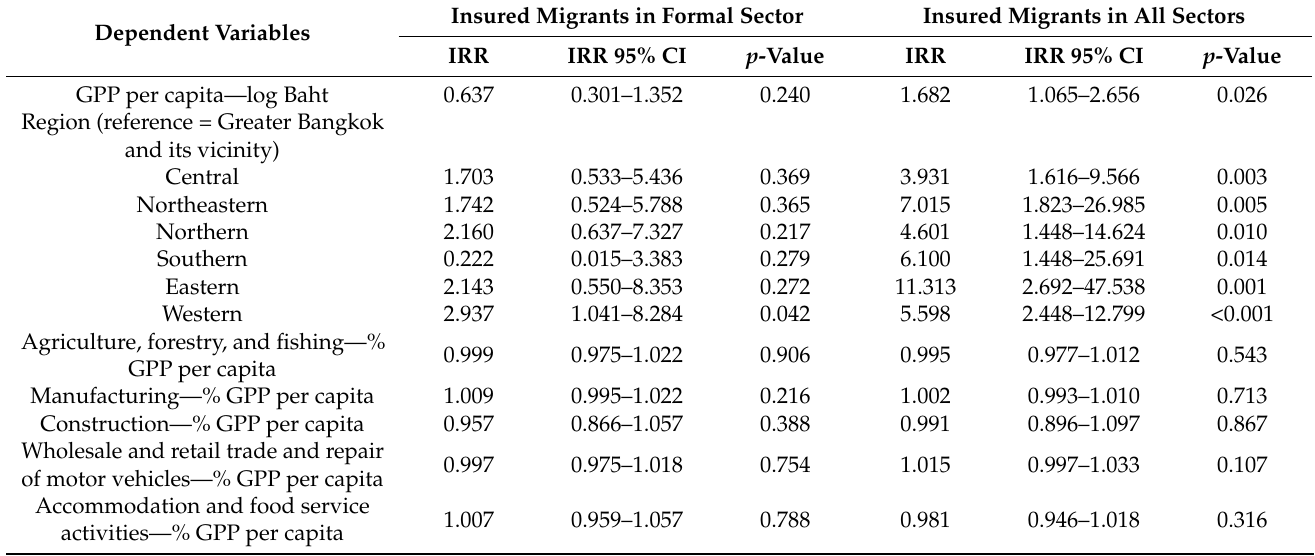
Table 4. Association between dependent variables (ratio of insured migrants to formal-sector migrants and ratio of insured migrants to all migrants) and all predictor variables by spatiotemporal